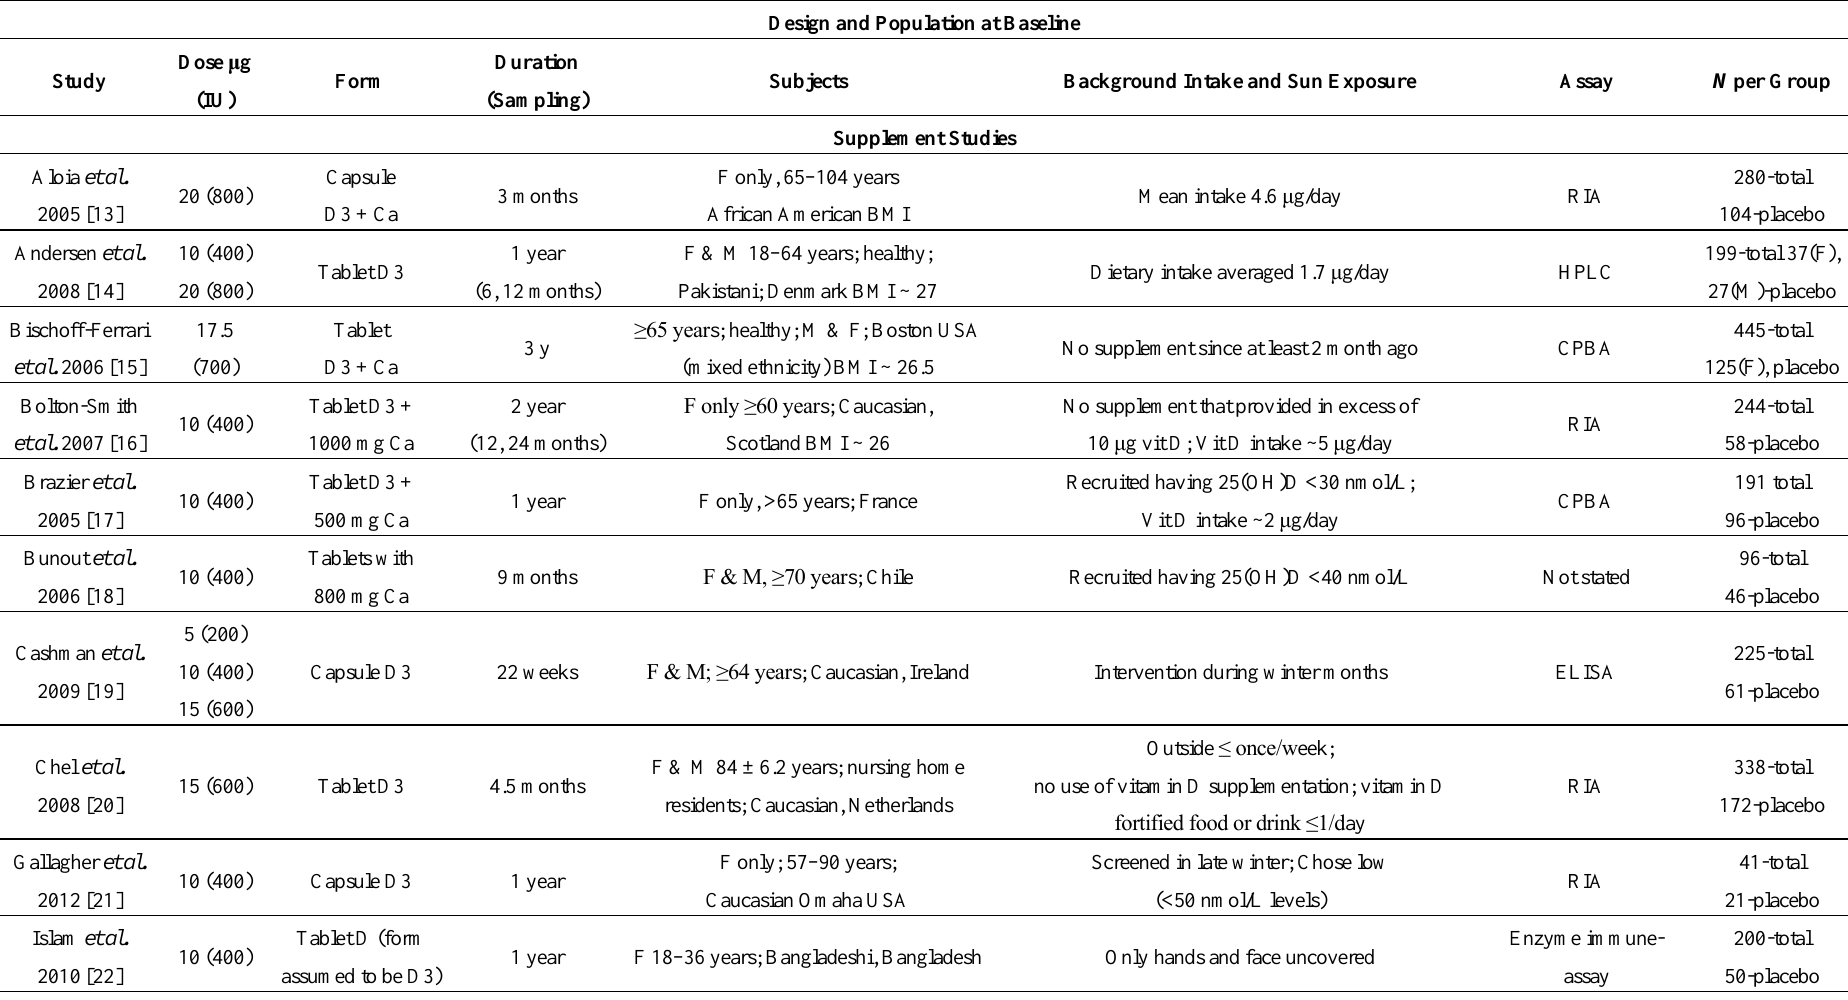
Table A1. Descriptive and baseline characteristics of vitamin D3 intervention